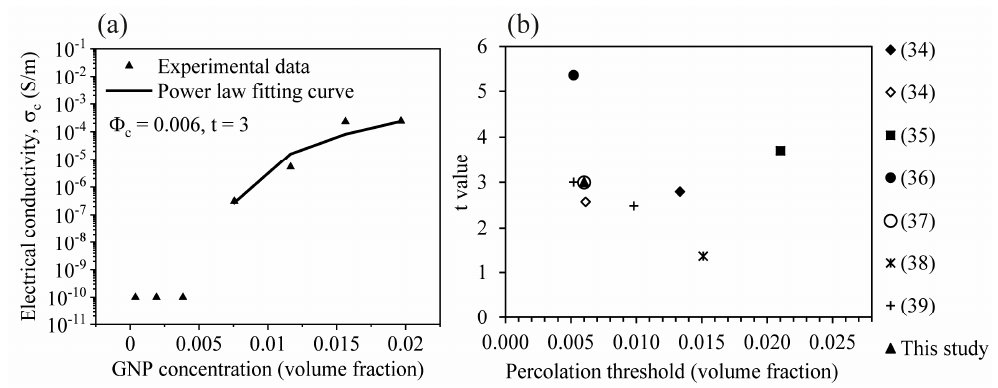
Figure 2. ( a ) Percolation threshold of the EP / GNP nanocomposites in this study and ( b ) comparison of percolation threshold and t values among EP / GNP nanocomposites from di ff erent